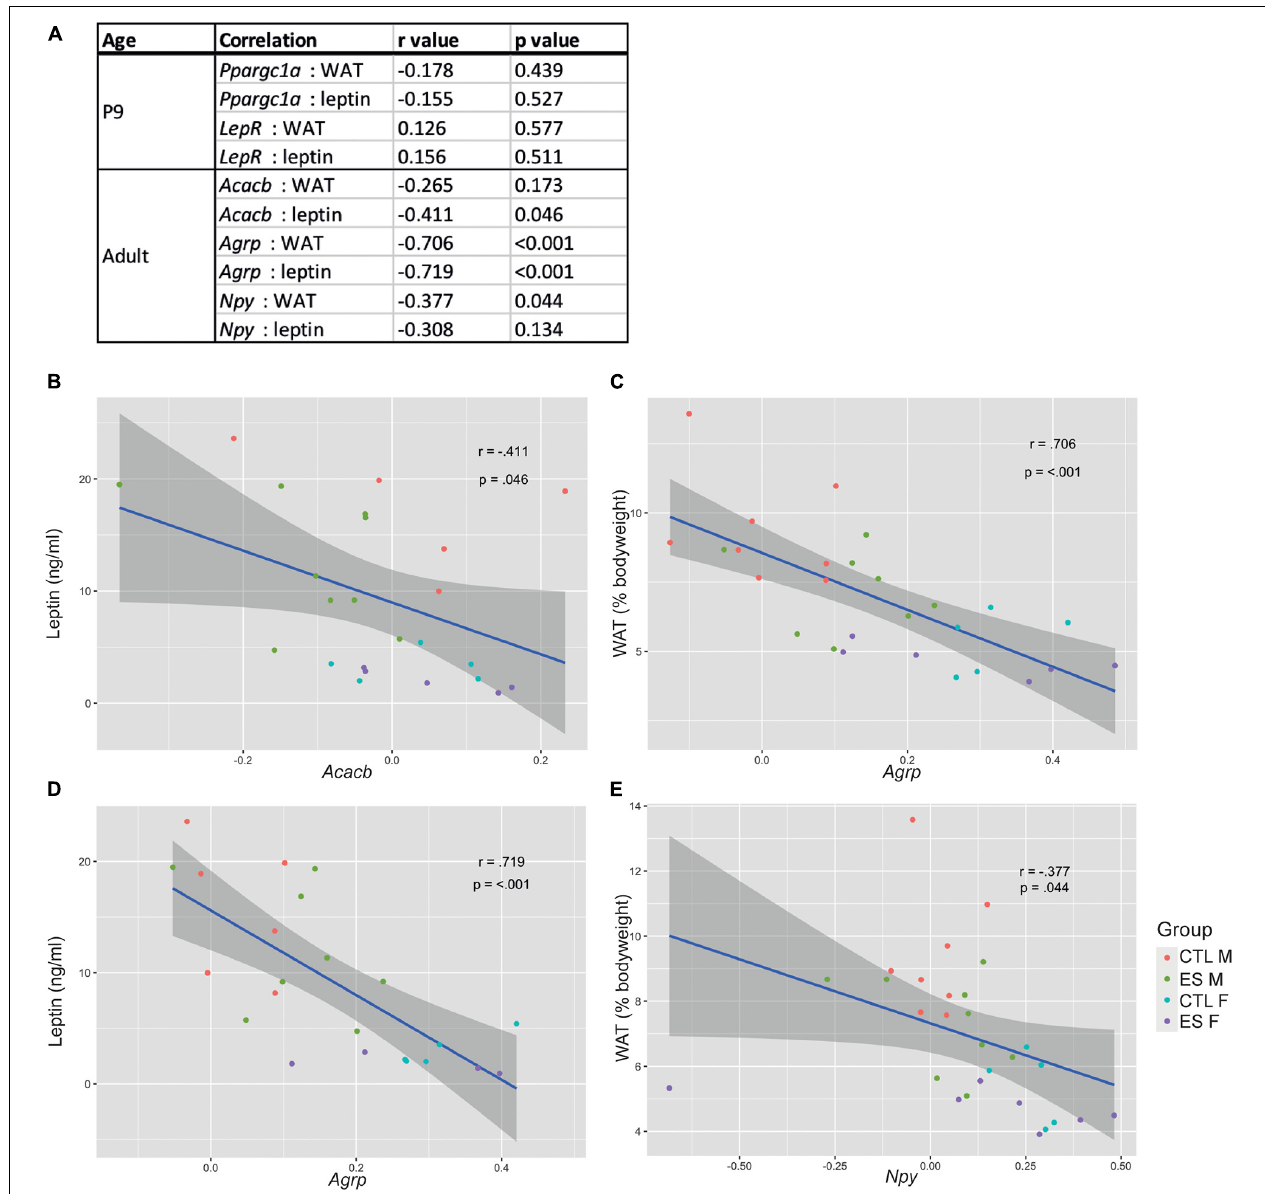
FIGURE 3 | (A) Correlations between significantly affected genes and metabolic readouts at P9 and in adulthood. (B) Acacb expression correlated with leptin levels. (C) Agrp expression correlated with white adipose tissue (WAT) levels. (D) Agrp expression correlated with leptin levels. (E) Npy expression correlated with WAT